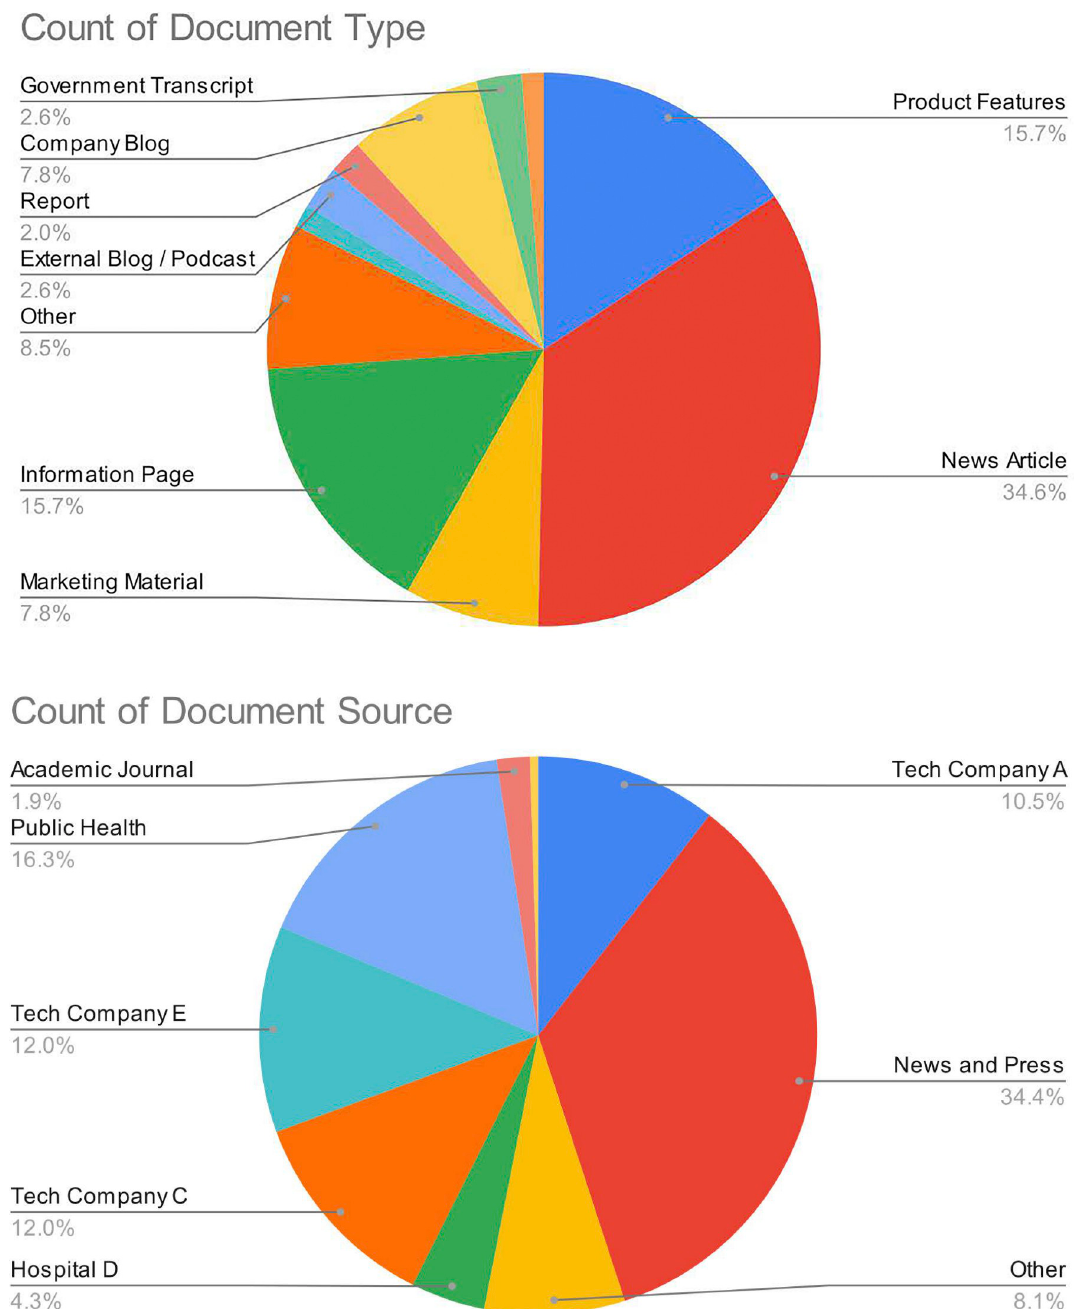
Fig 1. Summary of documents obtained. Pie charts of document type (A) and source (B) from document review, n = 210.